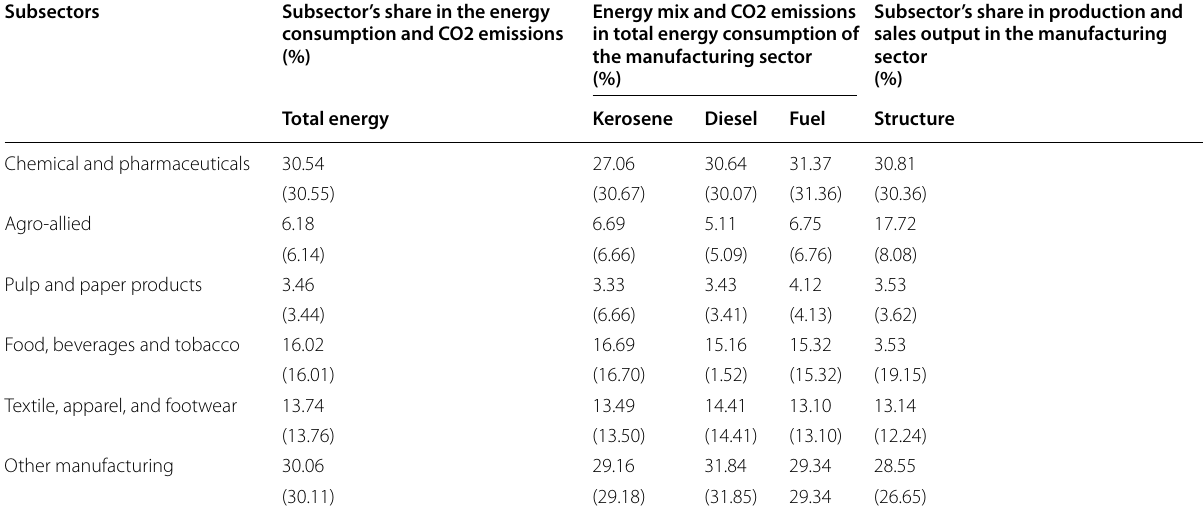
Table 3 The energy-related CO2 emissions and structure of the Nigerian manufacturing sector from 2010 to 2020 (selected subsectors)